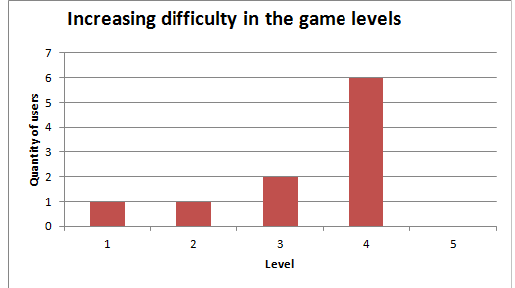
notice the increasing level of difficulty, which collaborates with the player motivation (Figure 25).